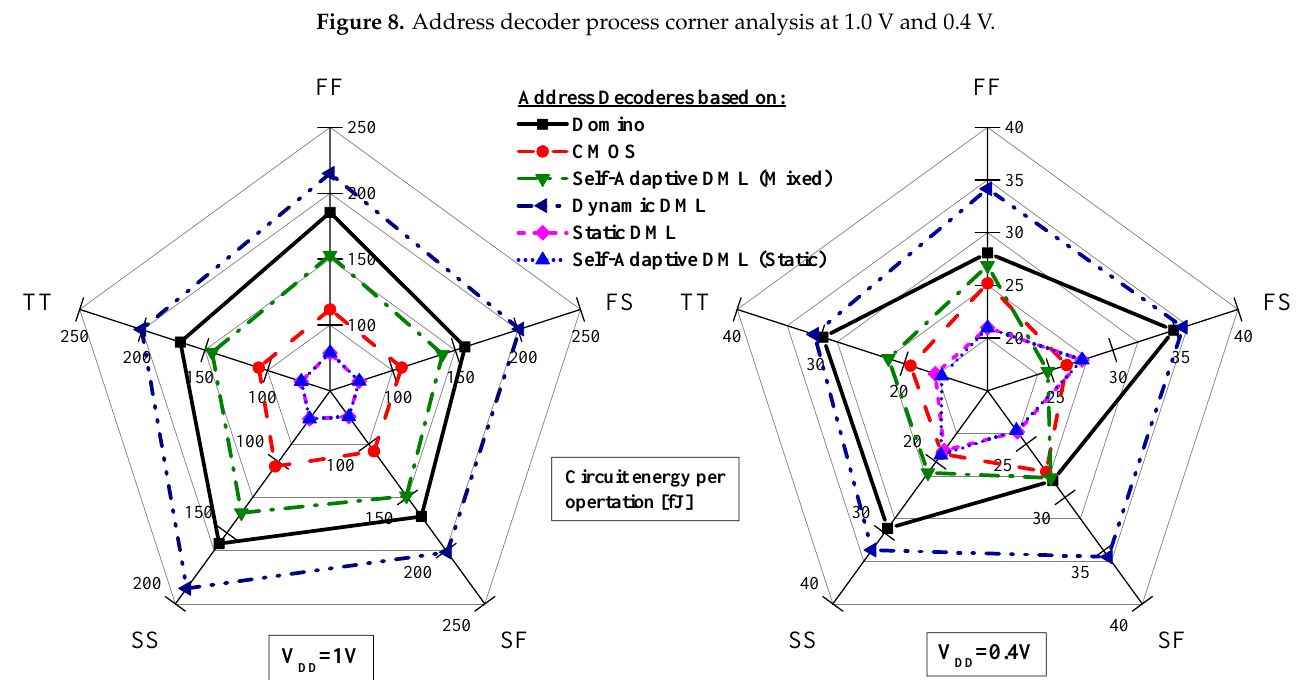
Figure 9. Address decoder process corner analysis at 1.0 V and 0.4